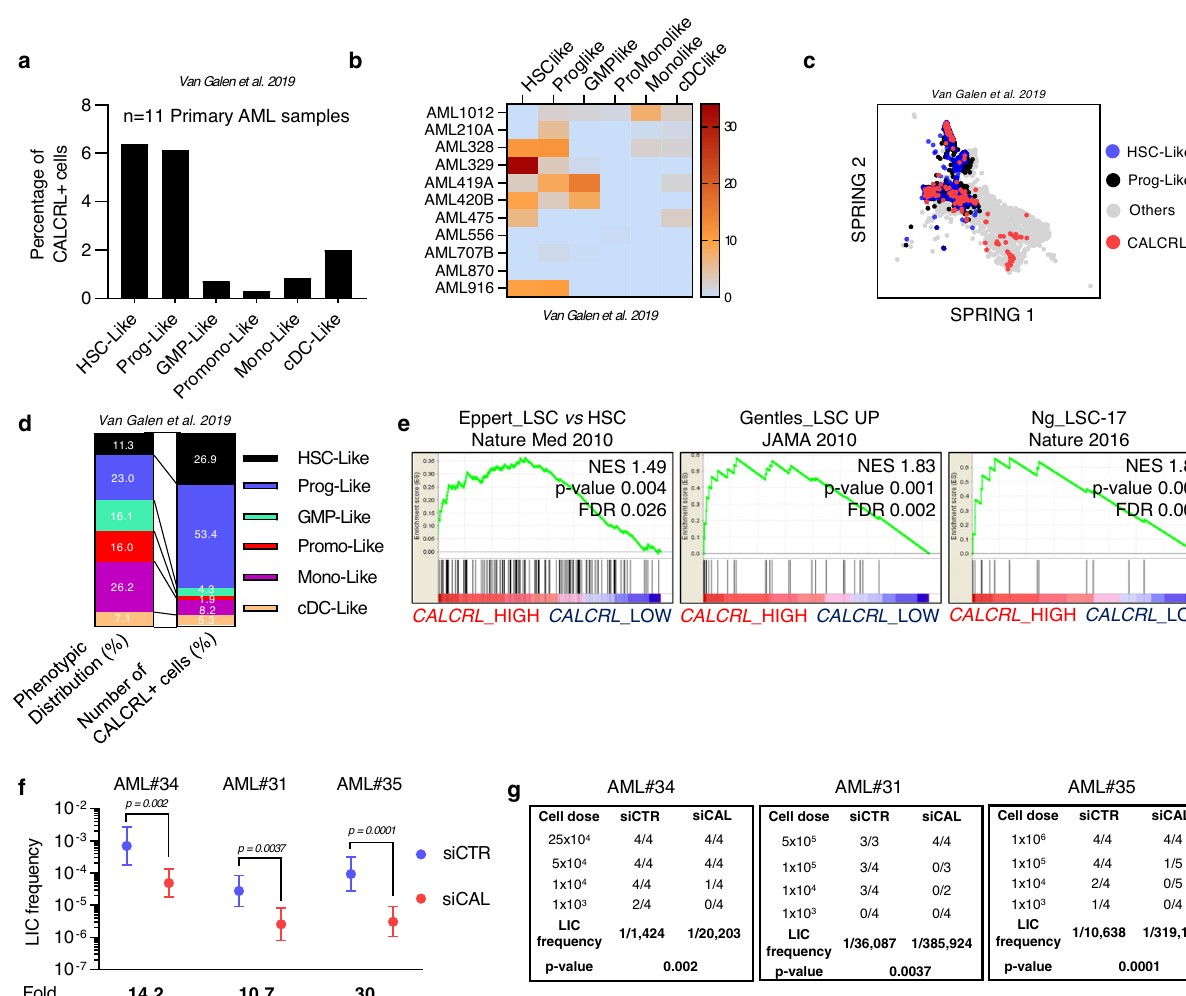
Fig. 3 CALCRL is required for leukemic stem cell maintenance. a Barplot shows the percentage of CALCRL positive cells in ( n = 11 primary AML samples) in cells classi fi ed as HSC-like, progenitor-like, GMP-like, Promonocyte-like, Monocyte-like, or cDC-like malignant cells (Van Galen et al. 2019) 31 . b Heatmap shows the percentage of CALCRL positive cells in each patient individually. c SPRING visualization of single-cell transcriptomes. Points are color-coded by indicated cell-type annotations. d Phenotypic distribution and number of CALCRL positive cells. e GSEA of stem cell signatures functionally identi fi ed by Eppert et al. 2 or phenotypically de fi ned by Gentles et al. 3 or Ng et al. 4 was performed using transcriptomes of cells expressing low (blue) vs high (red) levels of CALCRL gene (TCGA, AML cohort, Enrichment Score based on a Kolmogorov-Smirnov statistic). f Primary AML samples or cells from primary mice were collected and treated ex vivo with siCTR or siCALCRL and transplanted in limiting doses into primary or secondary recipients. Human marking of >0.1% was considered positive for AML engraftment except for AML#31 for which the cut-off was 0.5% because the sample was hCD33 − (Poisson statistic). g Engraftment results. Data are mean ± error bars (upper and lower limit, Poisson